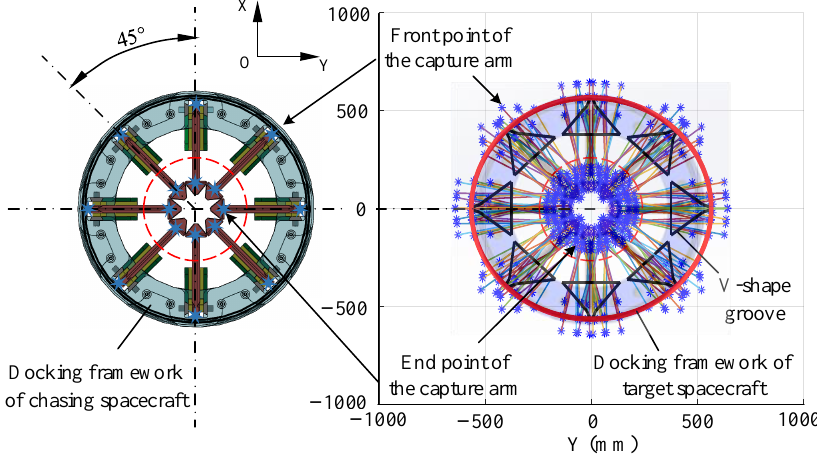
Figure 4. Initial posture conditions of the active capture arms.